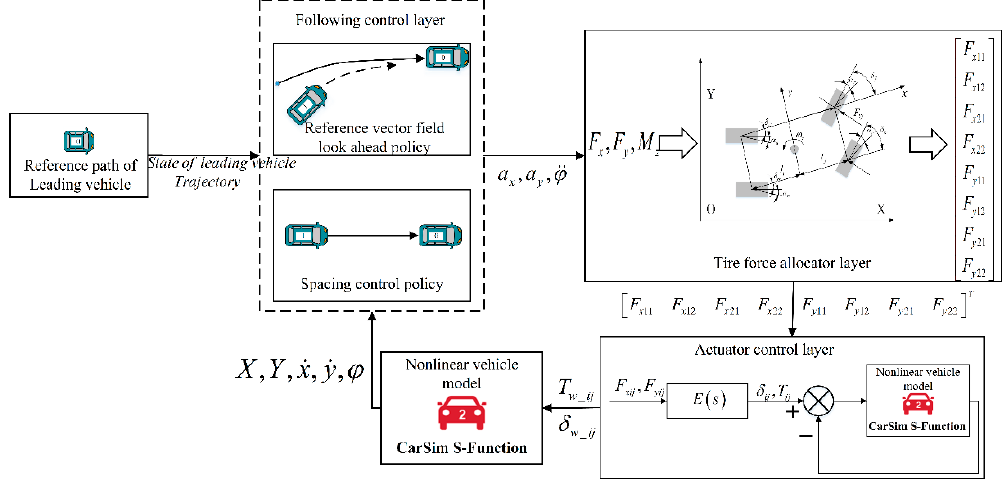
Figure 7. Structure of four-wheel independent driving and steering (FWIDSV) platoon following control.